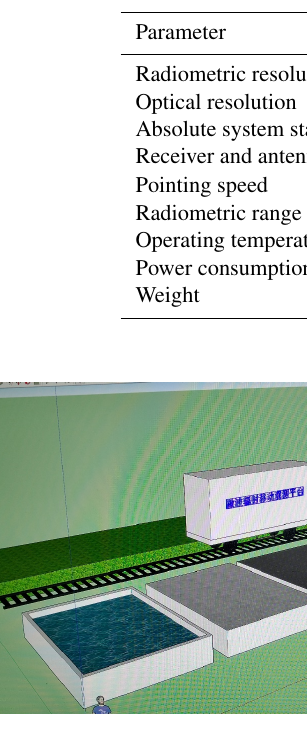
Figure 2. Sketch of the mobile platform.